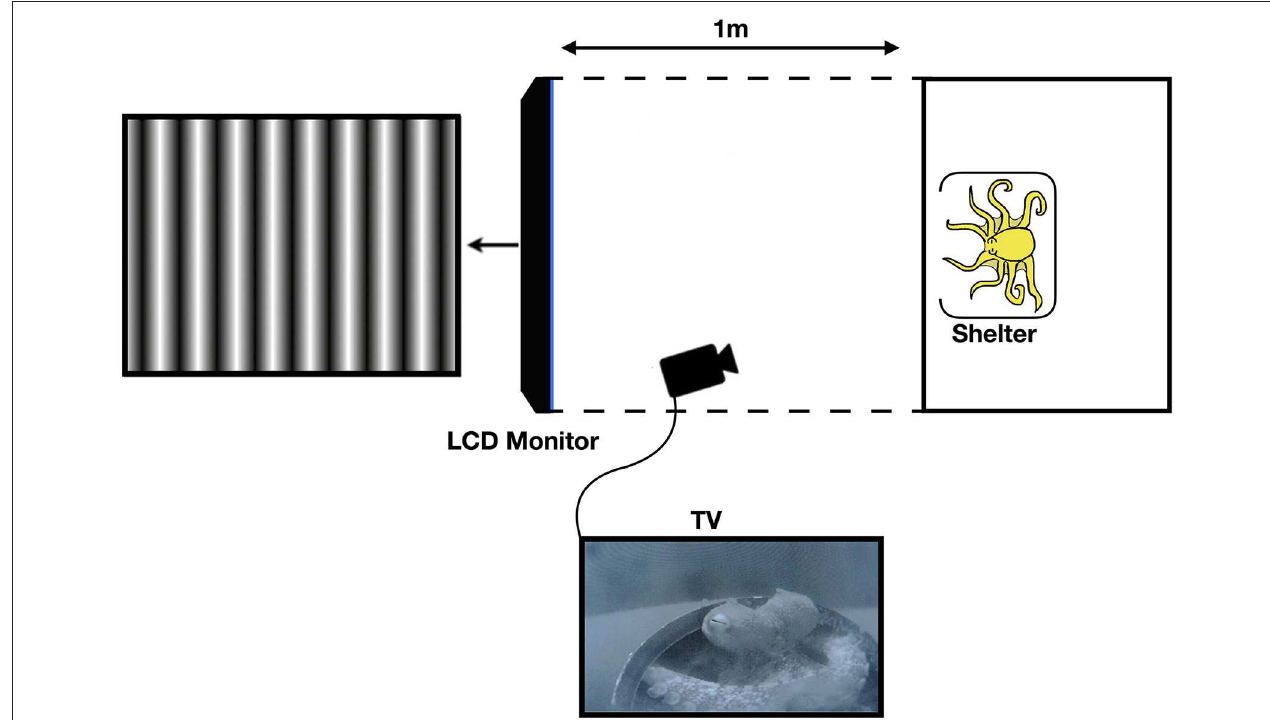
FIGURE 1 | Diagram of the experimental setup (not to scale). The black corrugated plastic tunnel blocks any stimulus outside of the tank apart from the LCD monitor. Reprinted with permission from Nahmad-Rohen and Vorobyev